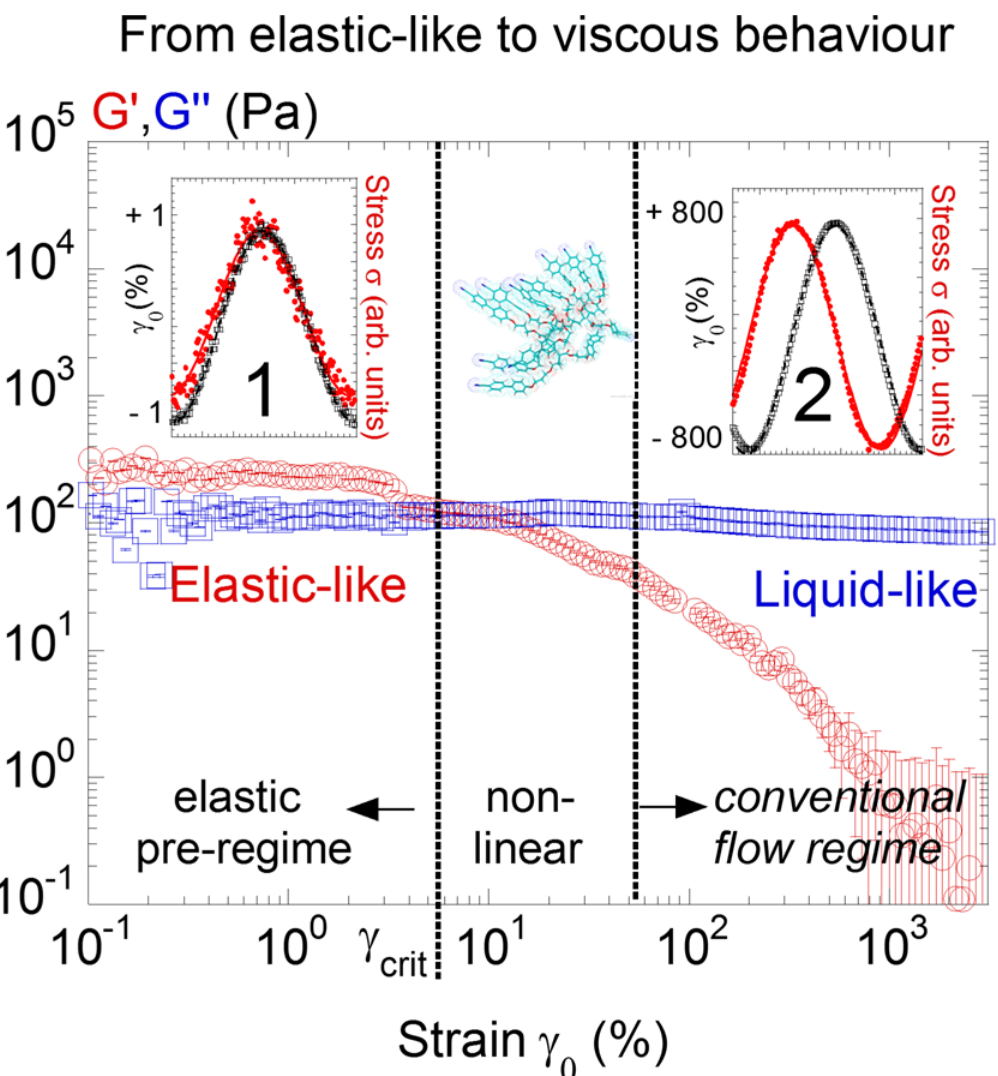
Fig 5. Identification of a elastic-like regime prior the Newtonian behavior in stress measurements: Stress dynamic moduli of LCF2 measured versus strain amplitude γ 0 at +25°C above the isotropic-smectic transition and for a gap thickness of 170 μ m. Elastic modulus G ’ (red circles, (cid:5) ) and viscous modulus G ” (blue squares, □ ) at a frequency of ω = 0.5rad s -1 . The vertical dashed bar delimits the elastic regime (elastic-like behavior) at small strains γ 0 from the flow regime (liquid-like behavior) at large strains γ 0 . Insets: Raw periodic stress (red full dot: (cid:129) ) and strain (black hollow circles: (cid:5) ) signals at small and large strain amplitudes ( γ 0 = 1.0% and at γ 0 = 800%